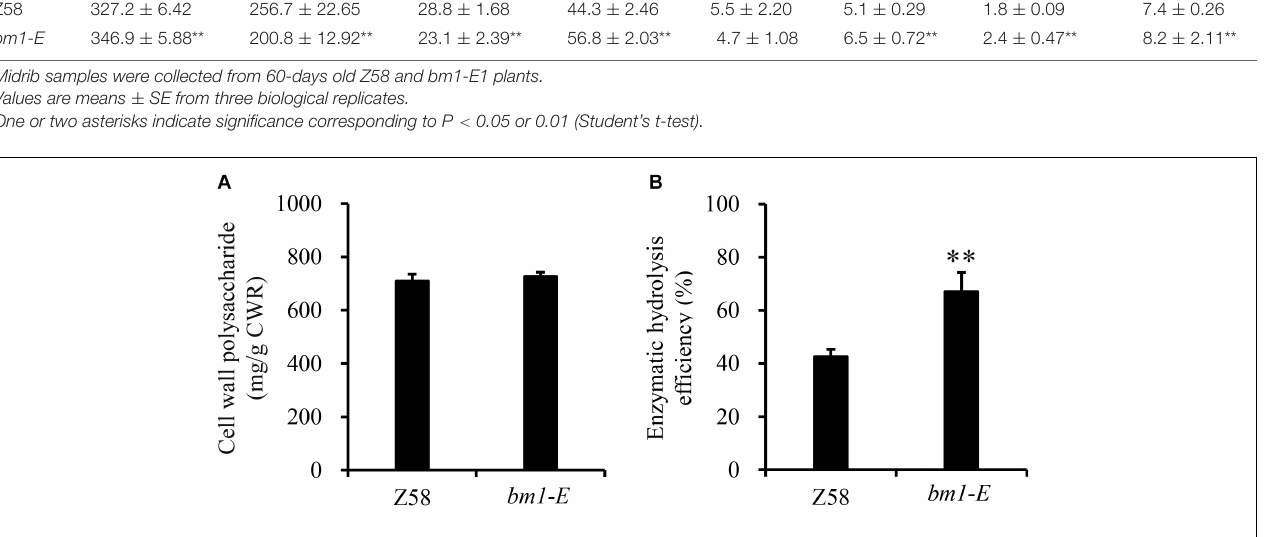
FIGURE 4 | Effect of bm1-E mutation on lignin content (A) and lignin composition (B) . Midribs of the second to fifth leaves from the top were collected from 60-days old bm1-E mutant and Z58 wild type maize. Values are means ± SE from three biological replicates. Two asterisks indicate significance corresponding to P < 0.01 (Student’s t -test). TABLE 2 | Cellulose content and monosaccharide composition (mg/g CWR) of non-cellulosic cell wall carbohydrates in Z58 and bm1-E plants. Plant Cellulose Xylose Arabinose Glucose Mannose Galactose Rhamnose Galacturonic acid